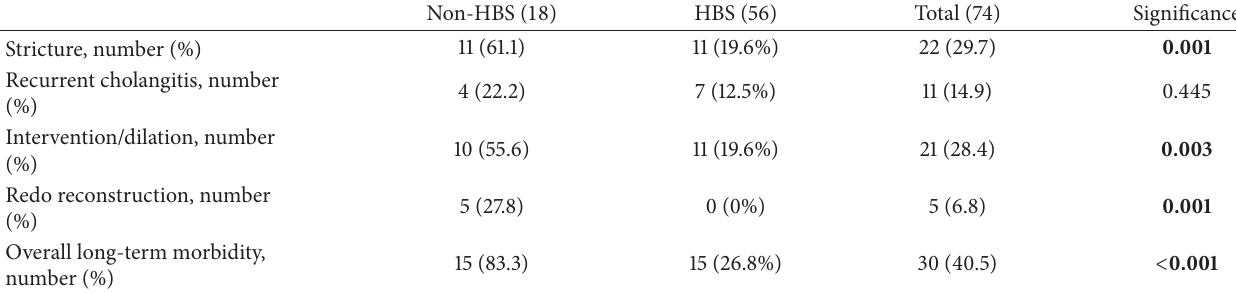
Table 4: Summary of long-term outcomes after surgical intervention to BDI; results by surgeon group.